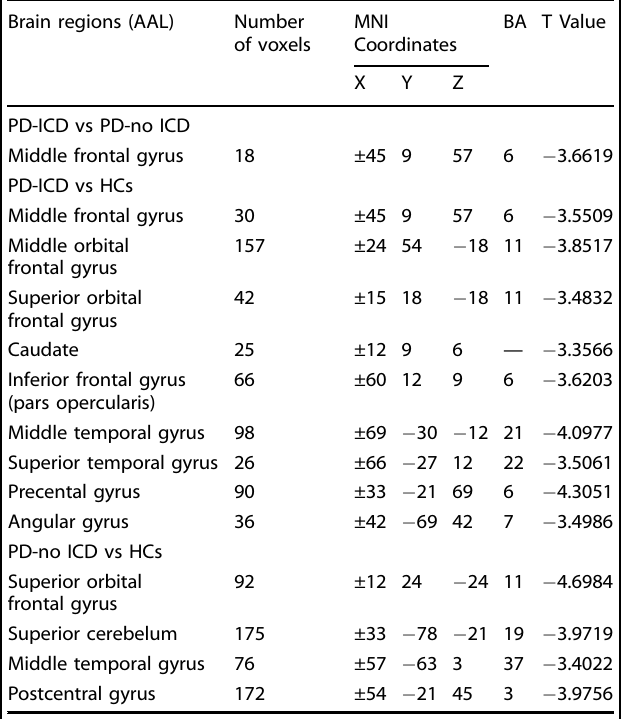
Table 2. VMHC differences among PD-ICD patients, PD-no ICD patients, and health controls during ON phase. Brain regions (AAL)